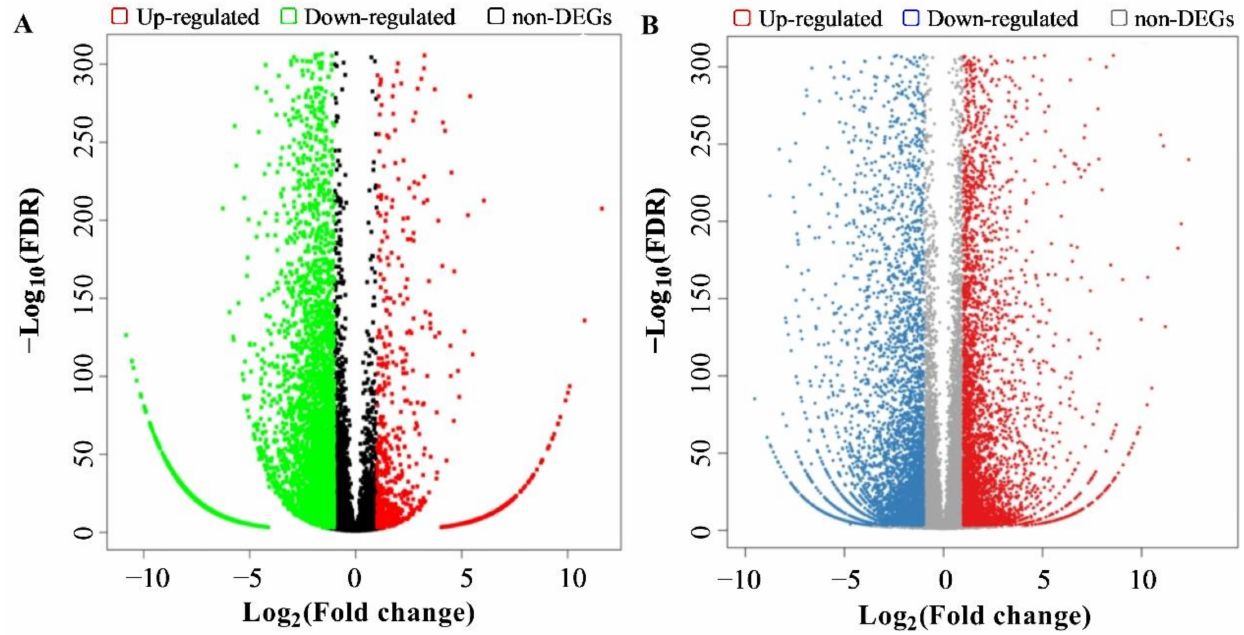
Figure 1. High-throughput small RNA and mRNA sequencing revealed abortion-related miRNA and genes in lotus flower buds. Volcano plots of differentially expressed small RNAs ( A ) and genes ( B ) between normal and aborting flower